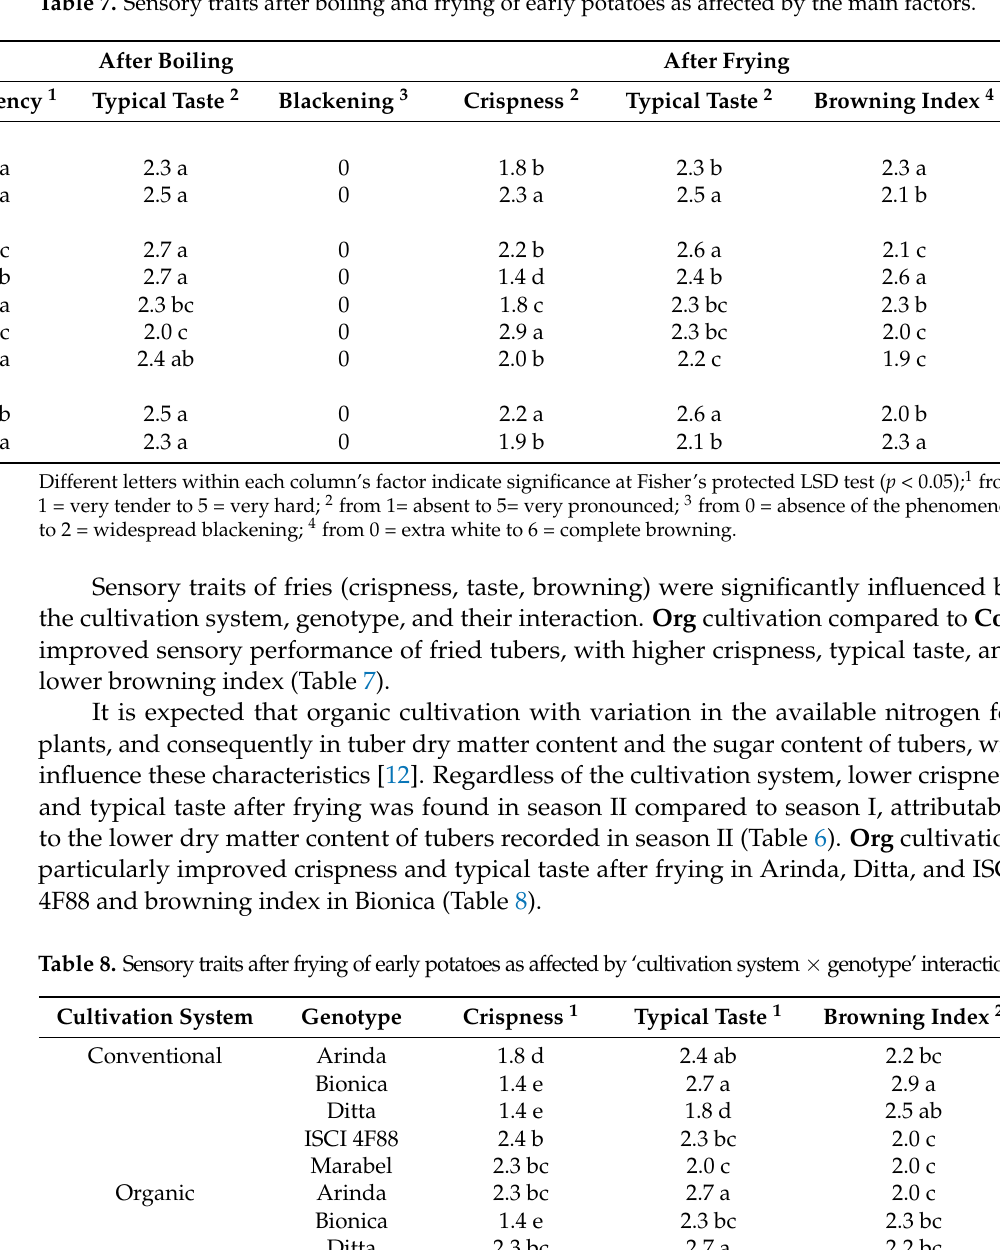
Table 7. Sensory traits after boiling and frying of early potatoes as affected by the main factors.